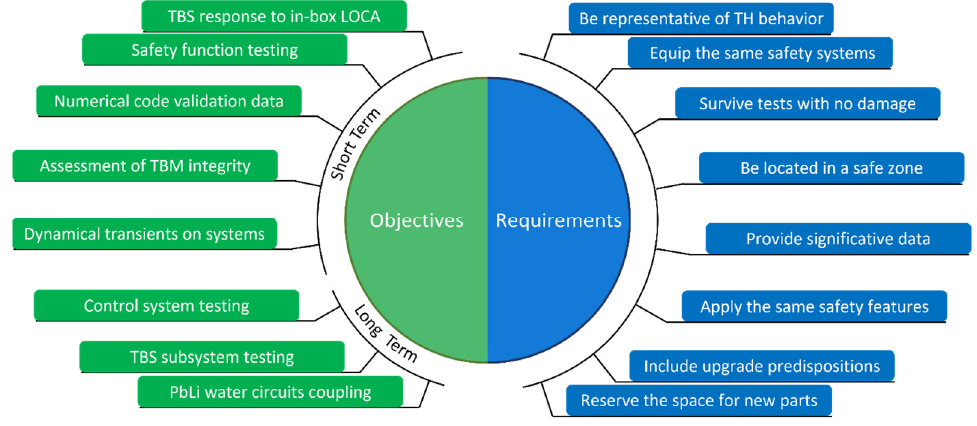
Figure 1. Objectives and requirements of LIFUS5/Mod4 facility.